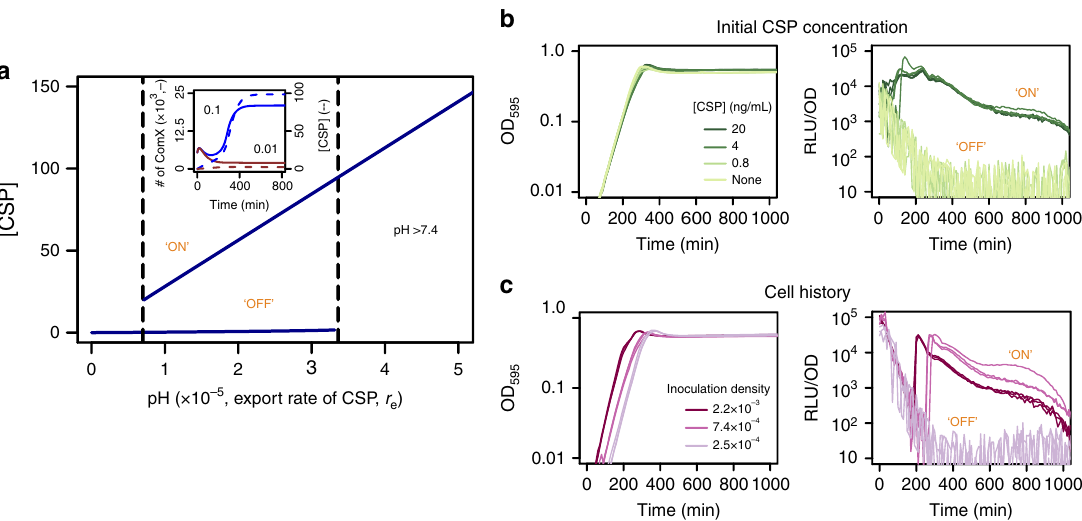
Fig. 6 A bistable regime for competence development. a Extracellular concentration of CSP in response to the rate of CSP export. The model predicts the existence of a region where competence always switches on regardless of the initial conditions (which would correspond to pH > 7.4) and of a bistable region (bordered by the dashed lines ). In the latter, the initial conditions can either switch on or not CSP production and subsequently competence development. (inset) In particular, the model predicts that in this region non-acid cell history can allow competence development if enough cells are inoculated since they can produce enough CSP to remain competent. The simulated inoculation densities are 0.1 ( blue ) and 0.01 ( brown ) and both the number of ComX molecules per cell ( solid line ) and the CSP concentration ( dashed line ) are shown. b Growth curves and competence expression measured as RLU units normalized by density for cells coming from acid preculture (pH 6.8) and inoculated in medium at pH 7.4 with different initial concentrations of CSP. Three replicates are shown per treatment and all the cultures are inoculated at OD 595 0.002. c Growth curves and competence expression measured as RLU units normalized by density for cells coming from non-acid preculture (pH 7.9) and inoculated in medium at pH 7.4 at different initial densities. Three replicates are shown per inoculation density. Competence does not develop for cells inoculated at the same densities but coming from acid preculture (pH 6.8) (Fig. 5b, left panel , second column